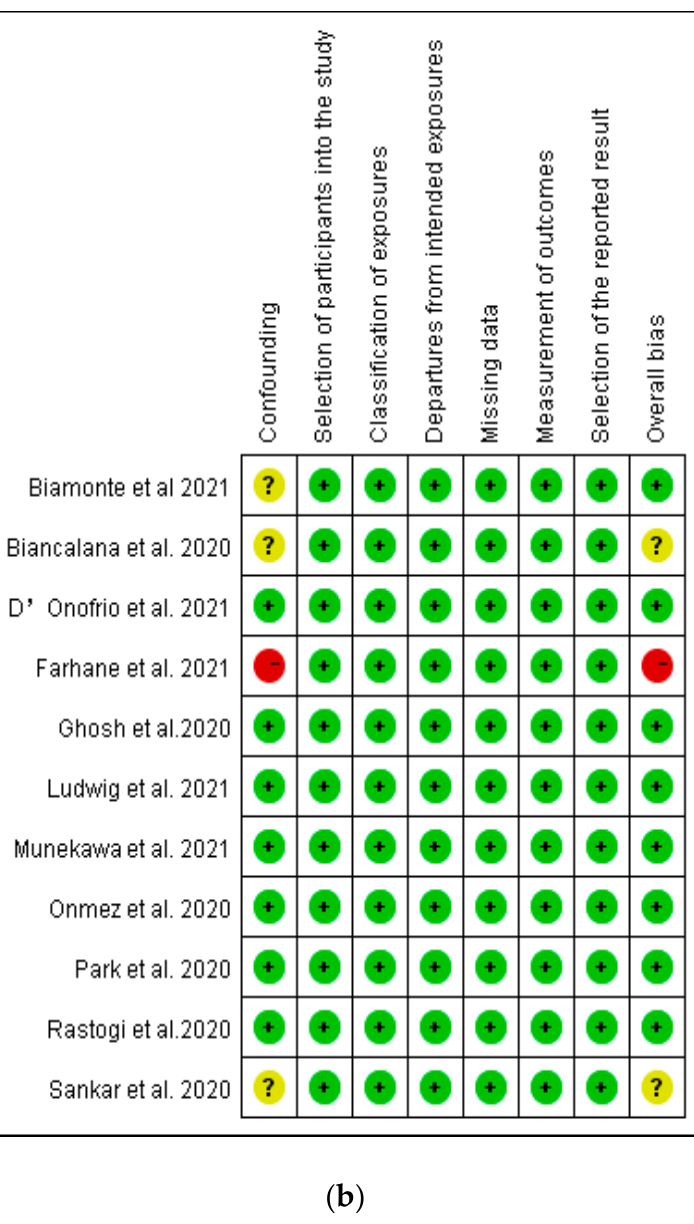
Figure 2. shows ( a ) risk of bias graph and ( b ) risk of bias summary. Figure 2. Shows ( a ) risk of bias graph and ( b ) risk of bias